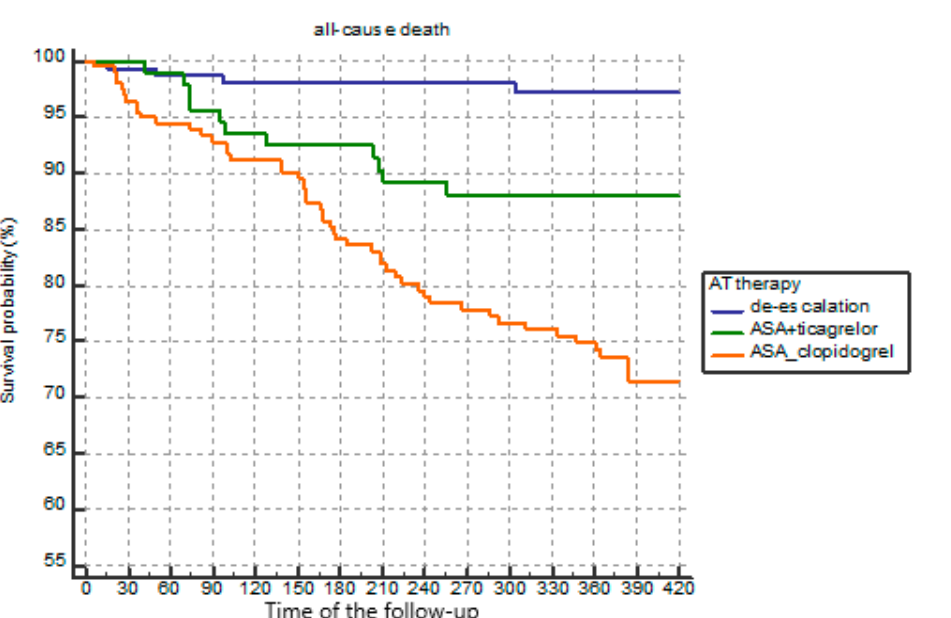
Figure 5. Survival probability of patients under 67 years depending on the APT options (Kaplan– Meier analysis).